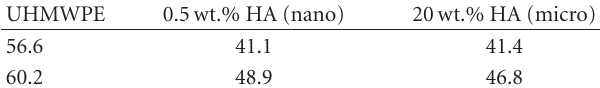
Table 2: Crystallinity ( χ , %) in UHMWPE-based composites. UHMWPE